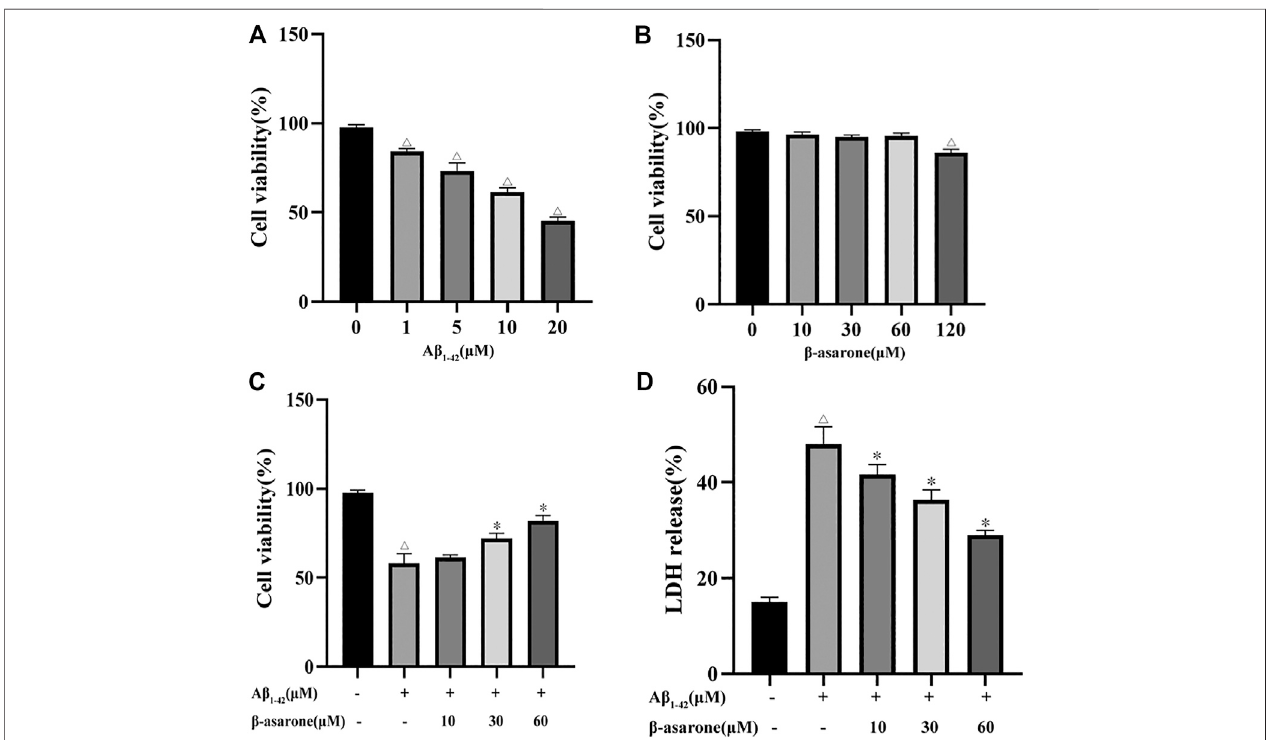
FIGURE 1 | Effect of β -asarone on A β 1 – 42 -induced cytotoxicity. PC12 cells were treated with different doses of A β 1 – 42 (0, 1, 5, 10, and 20 μ M) for 12 h (A) or β -asarone (0, 10, 30, 60, and 120 μ M) for 12 h (B), and cell viability wasdetected byusing the MTT assay. PC12 cells were treated with 10 μ M A β by β -asarone treatment for another 12 h, and subjected to MTT assay (C) and LDH release tests (D) . △ p < 0.05 compared with the control group; * p < 0.05 compared with the A β 1 – 42 -alone treatment group. Each column represents mean ± SD, and each experiment was repeated three times.